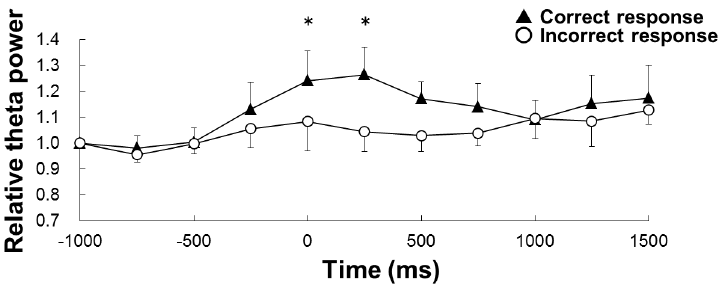
Figure 7. Comparison of hippocampal theta power between correct-response and incorrect-response trials. This figure shows the hippocampal theta power between trials with correct lever press response for RFT and incorrect lever press responses for non-RFTs during the late stage of the negative patterning task. The 0 period was lever press timing. The analysis period from 1250 ms before lever press to 1500 ms after lever press was divided into 11 250-ms epochs. The 250-ms period from -1250 to -1000 ms was used as the baseline, and the relative theta activity for each period was calculated as follows: relative theta activity of each period = theta activity of each period/theta activity during the baseline